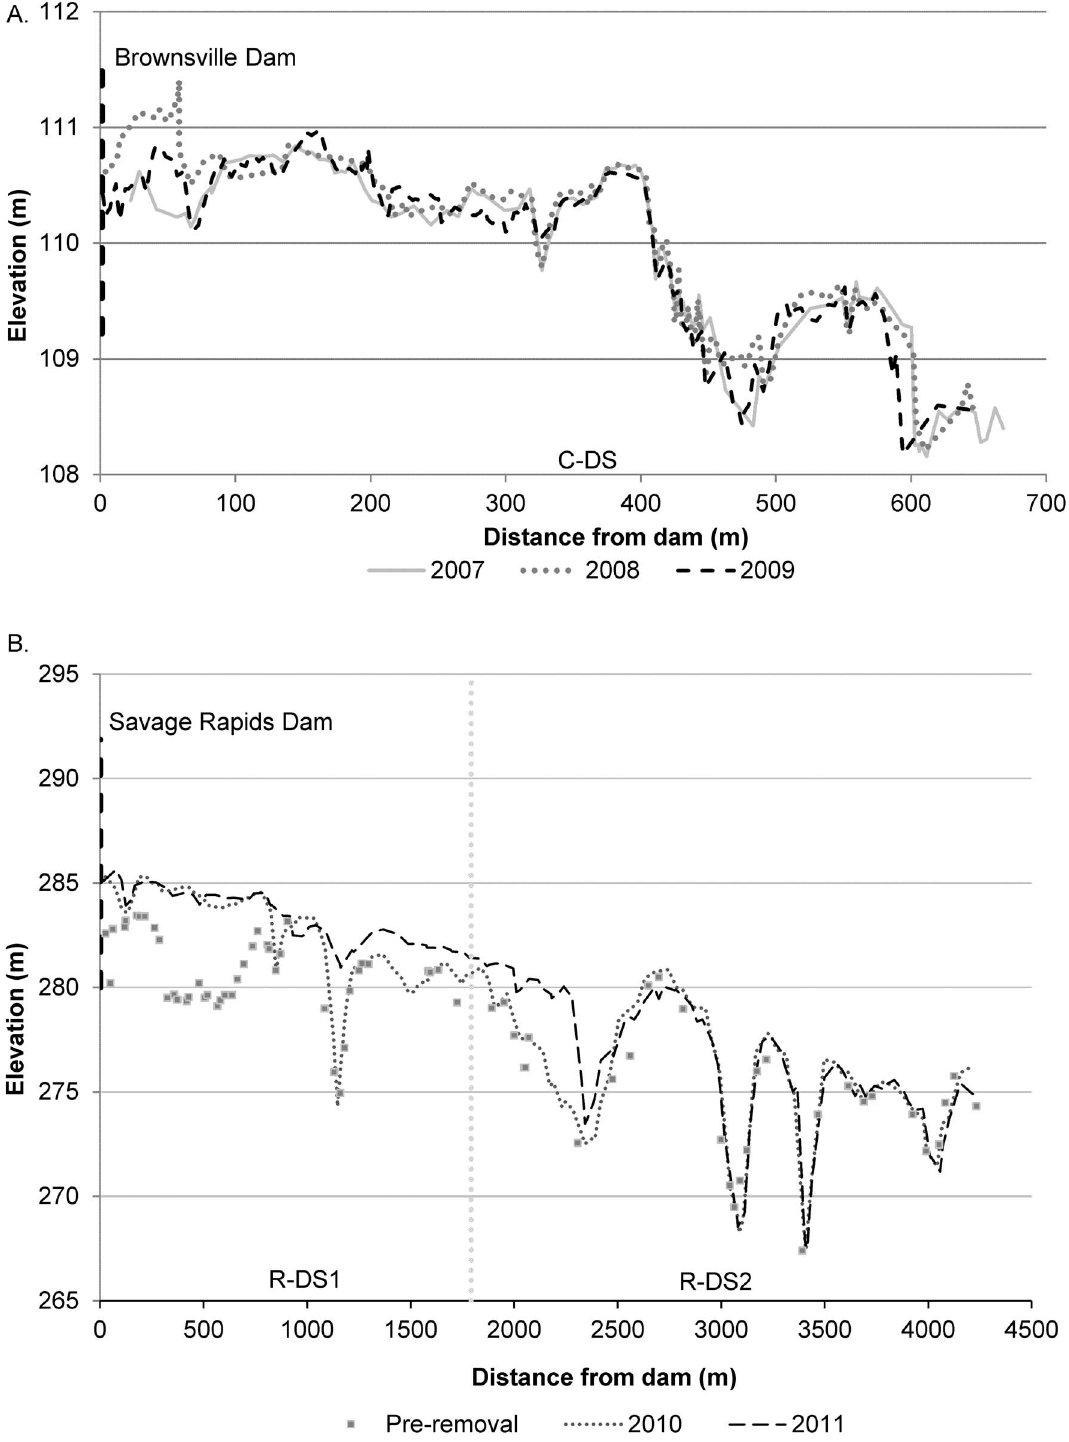
Figure 3. Longitudinal profiles downstream from the dams over time at a) Calapooia River and b) Rogue River. On the Rogue River, no longitudinal profile was collected during 2009, and the pre-removal profile is a compilation of surveys from 1999 in the farthest US and DS reaches and from 2002 for the main reservoir, both conducted by the US Bureau of Reclamation. doi:10.1371/journal.pone.0108091.g003 evident as fining in R-DS1. In 2010, the first year post-removal, also underwent substantial fining in 2010 and the grain size and the grain size and RBS* values at R-DS1 were further reduced, bed stability remained low in 2011. Thus, while the grain size at and remained low in 2011, the second year post removal. R-DS2 the upstream control site varied little between years, the release of